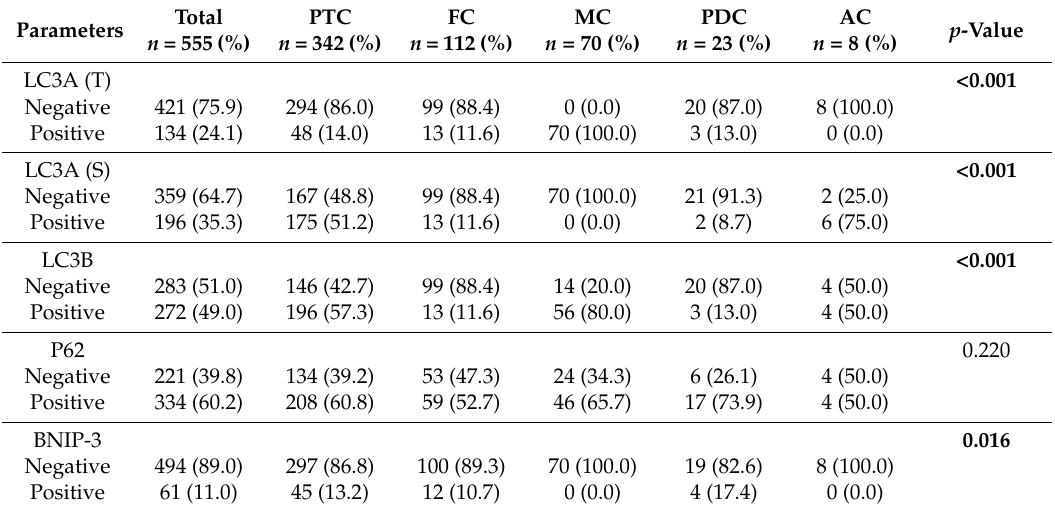
Table 1. Expression of autophagy-related proteins according to histologic thyroid cancer subtype.